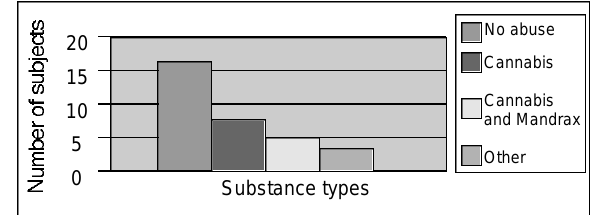
Fig. 2. Substances preferred by patient